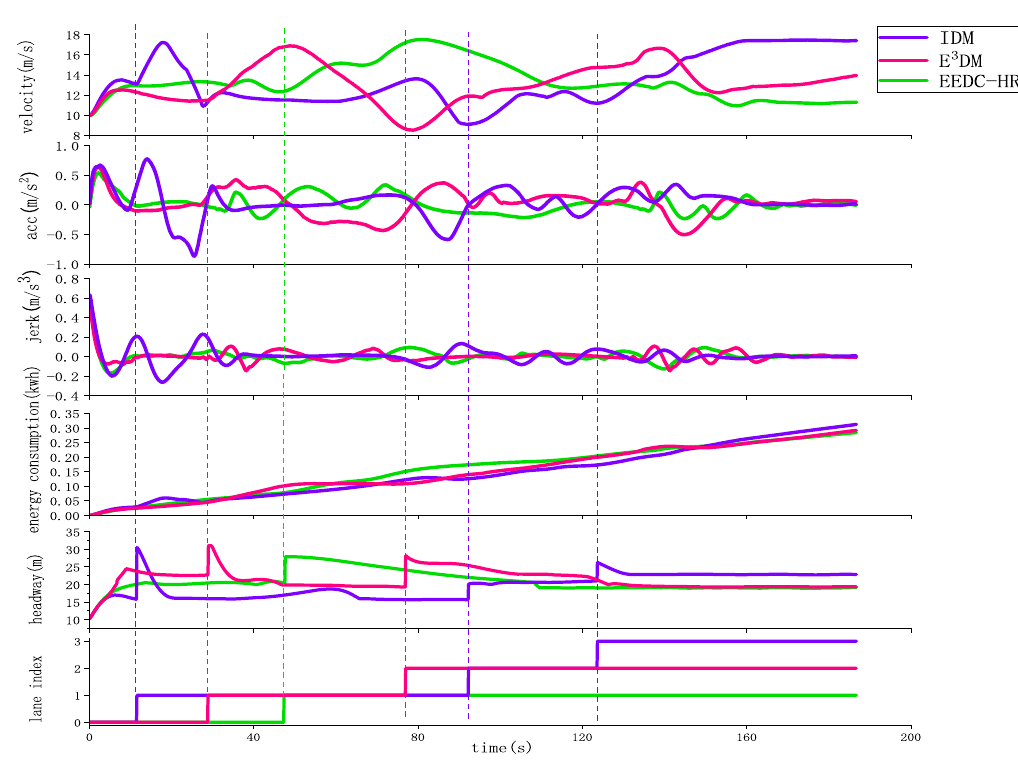
Figure 8 The sampled event in normal traf fi c